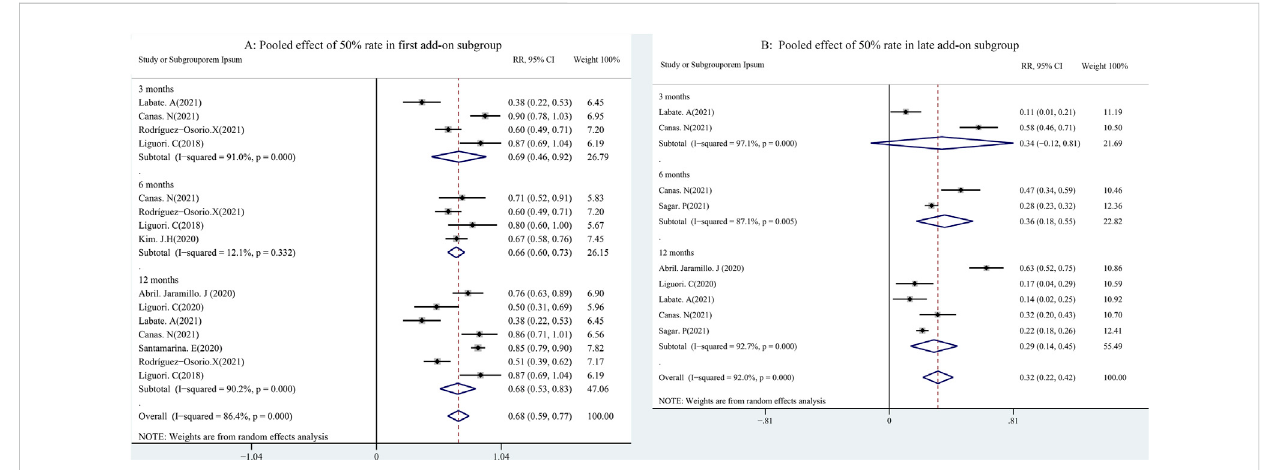
FIGURE 4 50% responder rate ( fi rst vs . second